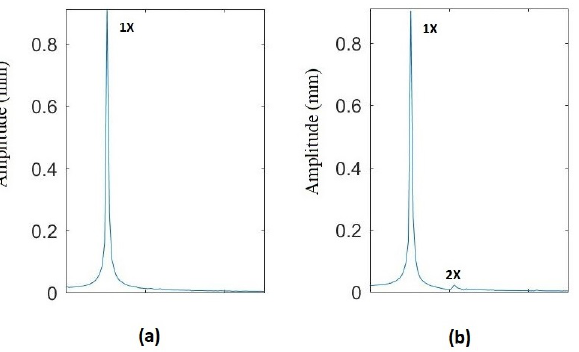
Figure 21. FFT at p = 0.433: ( a ) uncracked shaft and ( b ) cracked shaft α = 0.15.